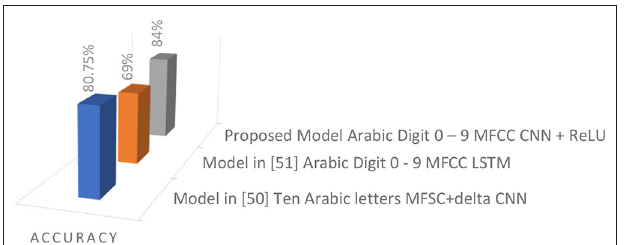
FIGURE 9 | Comparison of Accuracy.